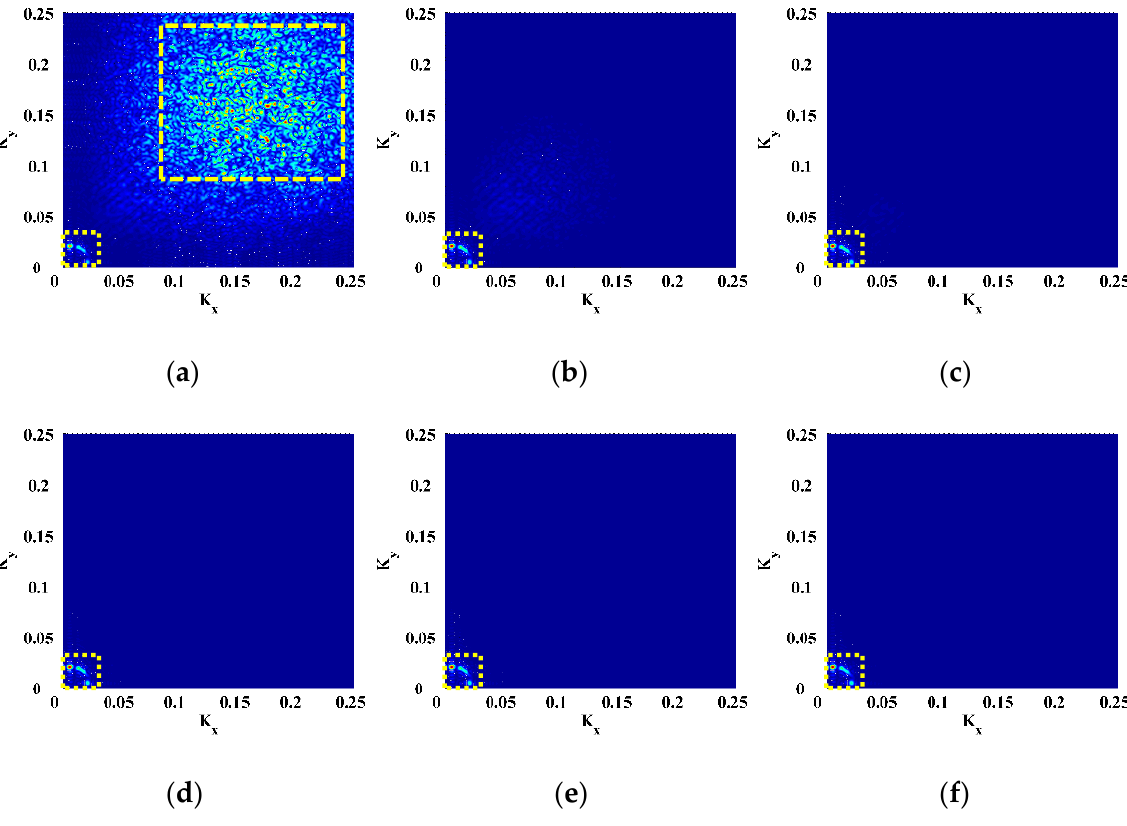
Figure 5. Wavenumber spectra of the MDIs for Scenario V with scale parameters of ( a ) 2, ( b ) 4, ( c ) 6, ( d ) 8, ( e ) 10, and ( f ) 12.